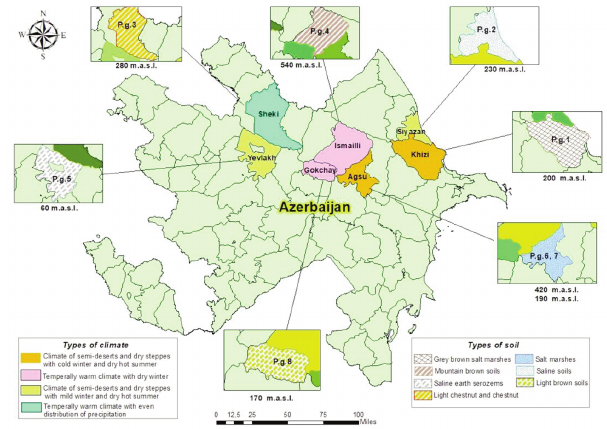
Fig. 1 ­ Selected sampling stations in Azerbaijan districts. The type climate and of soil of each district is reported. The pomegranate accession harvested in each area are also indicated on the